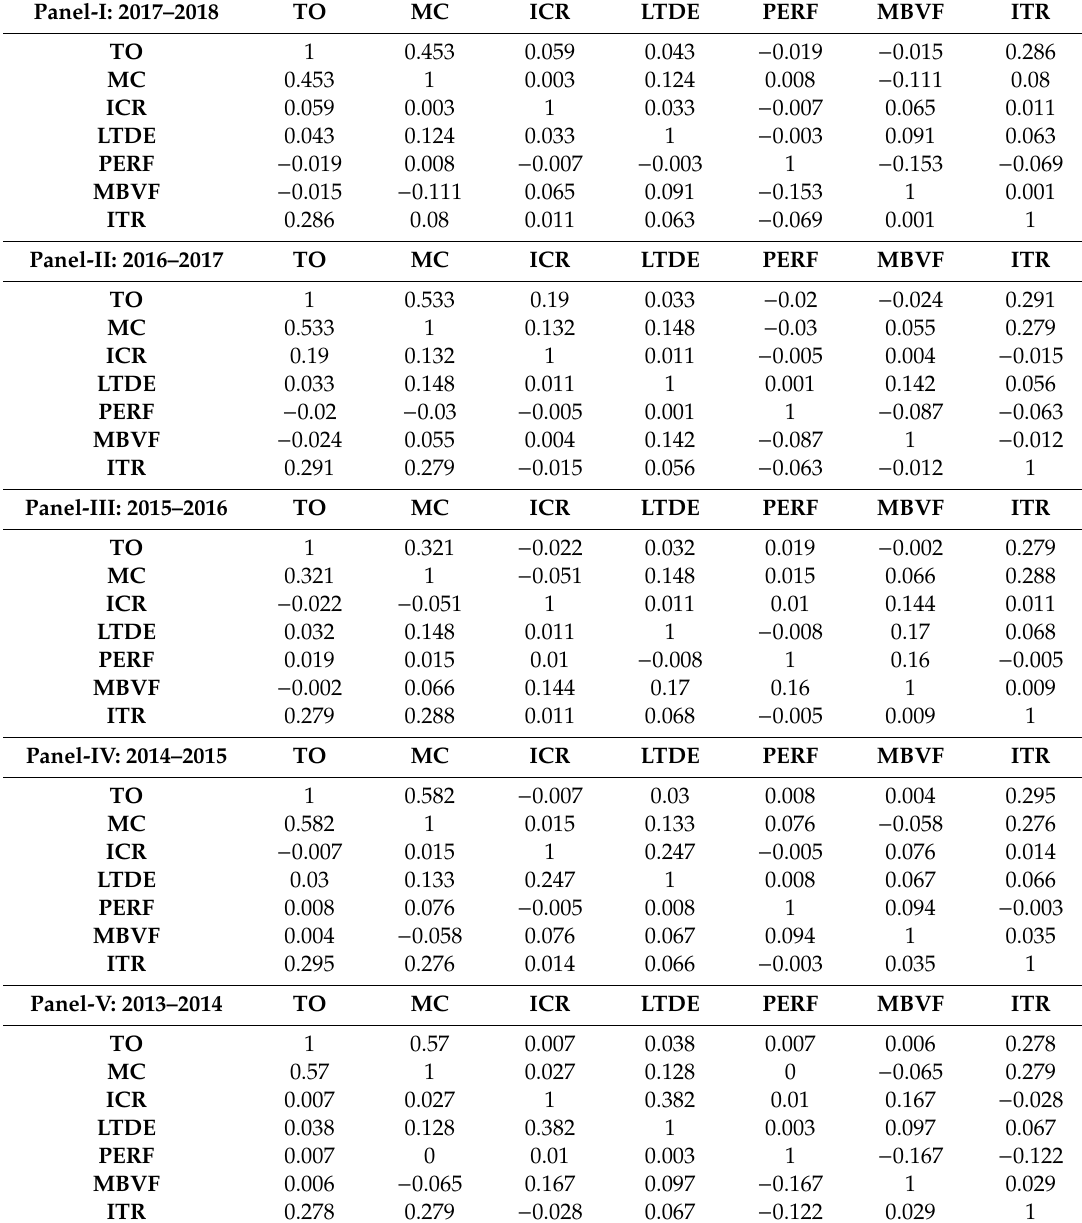
This table represents the correlation matrix of the independent variables used in the logistic regression model. In the table, Ln(TO) represents the natural logarithm of turnover, Ln(MC) represents the natural logarithm of market capitalisation, ICR represents the interest coverage ratio, LTDE represents the long-term debt to equity ratio, PERF represents the price–earnings ratio fraction, MBVR represents the market-to-book value ratio, and ITR represents the international transaction